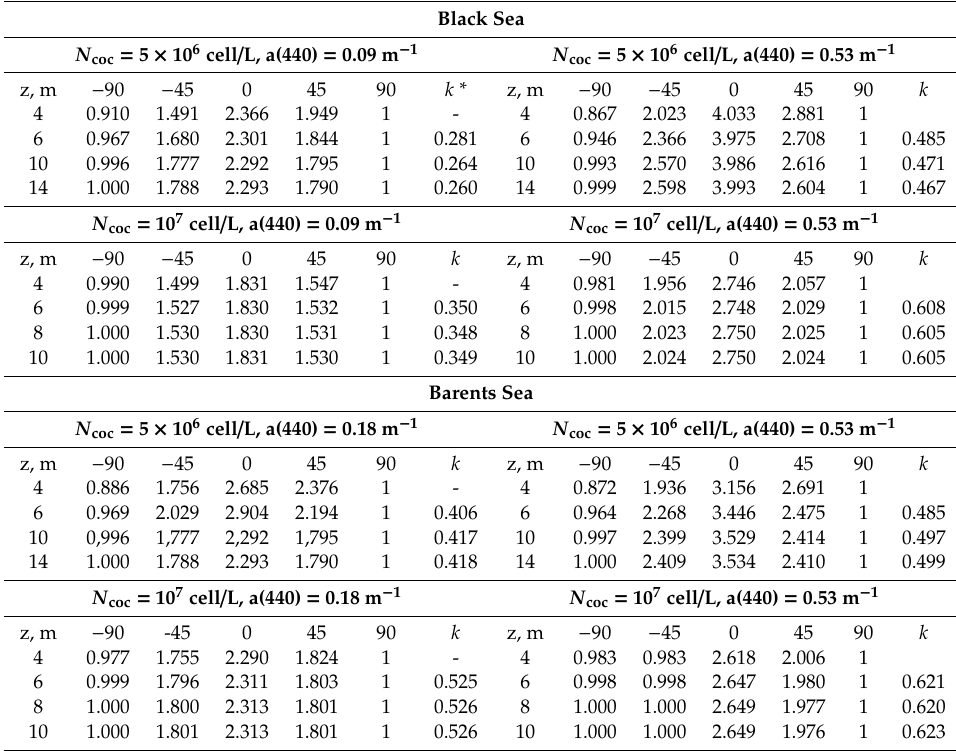
Table 3. Normalized angular distributions of underwater radiance in the Black Sea and Barents Sea. Black